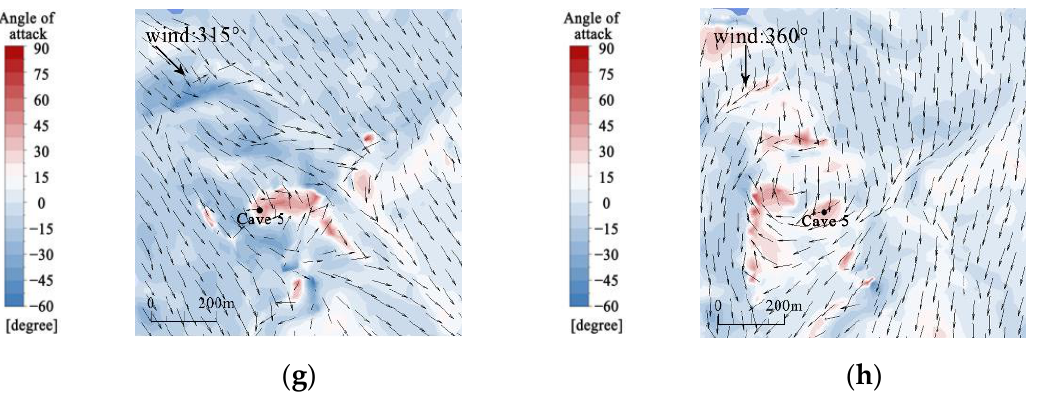
Figure 16. Colour contours of the angle of attack around Cave 5 for the inlet wind directions of 45° – 360°. ( a ) 45°; ( b ) 90°; ( c ) 135°; ( d ) 180°;( e ) 225°; ( f ) 270°; ( g ) 315°; ( h ) 360°.